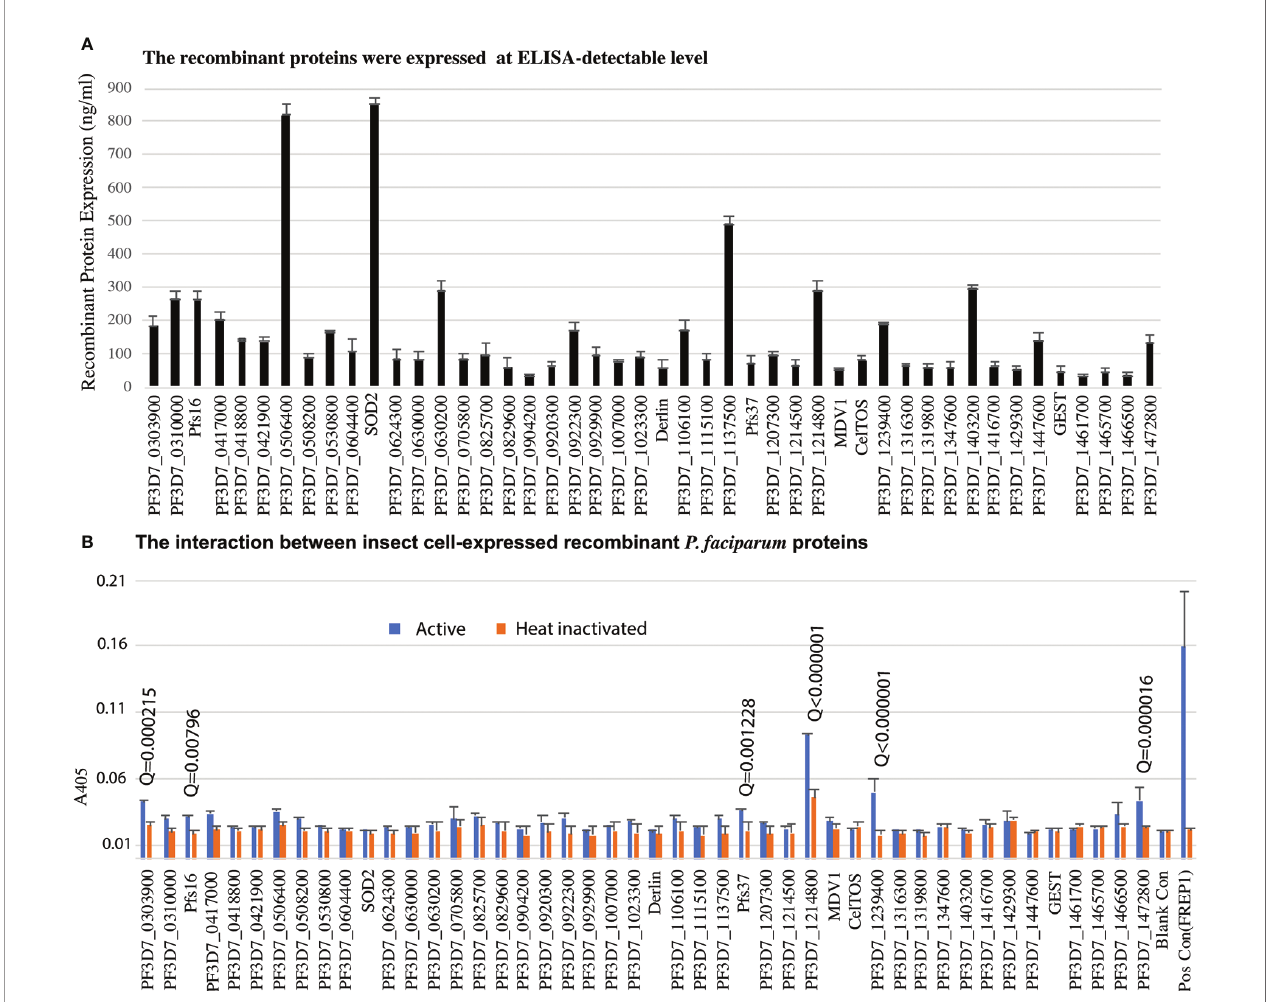
FIGURE 3 | The insect-cell expressed recombinant parasitic proteins and their interaction with midguts. (A) The expression of candidate proteins in high fi ve cells. Totally, forty-six genes were expressed in high fi ve cells with a baculovirus expression system at a detectable level. Each sample was measured with triplicates. The expression experiments were conducted three times. (B) Interaction between recombinant proteins and midgut lysate. The concentration of recombinant proteins was normalized. Naïve recombinant proteins and heat-inactivated proteins were used as experimental groups and control groups with triplets. The false discovery rates (Q) were calculated by multiple t-test using the Two-stage linear step-up procedure (Benjamini et al., 2006). Those proteins with Q <1% were labeled with the Q values. The same experiments were repeated three times, and the results were similar.